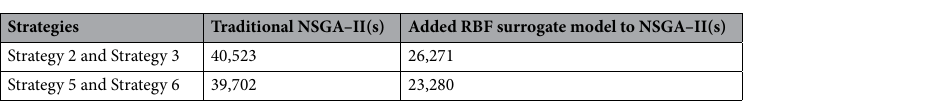
Table 4. Comparison of time consumption between applying the traditional NSGA–II and introducing the RBF surrogate model.